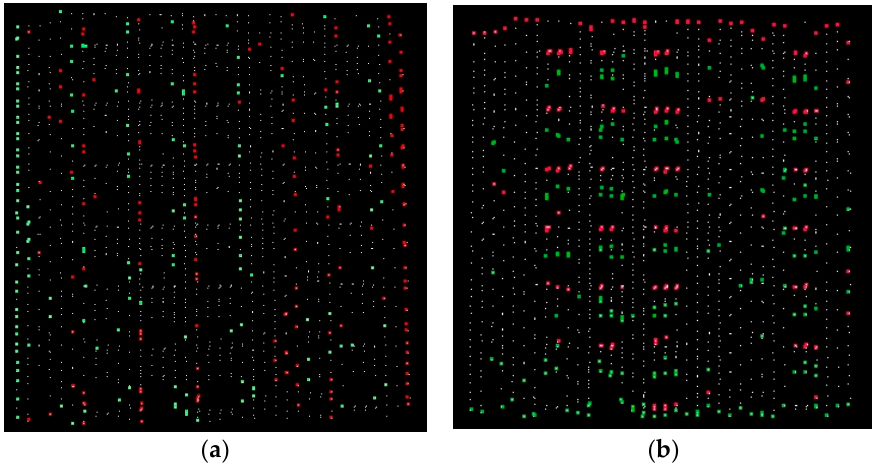
Figure 12. The window’s edges detection: ( a ) the left and right edges detection; and ( b ) the upper and lower edges detection.